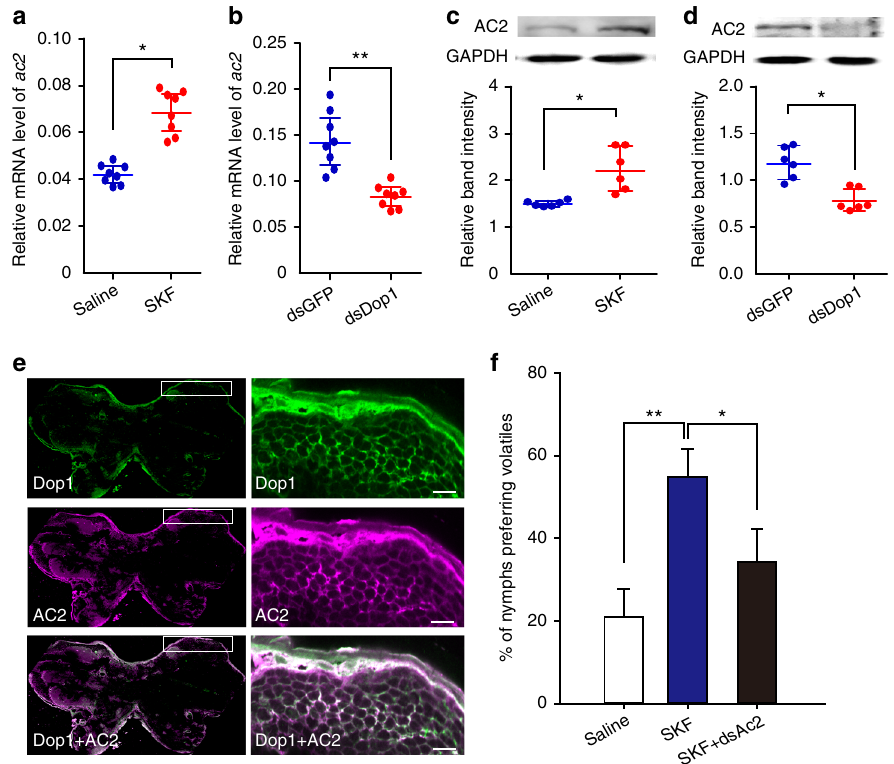
Fig. 6 ac2 responds to Dop1 administration in the brain of migratory locust. a , b The qPCR analysis showed that the mRNA level of ac2 was upregulated by SKF injection in the solitarious brains ( a , n = 8) but downregulated by dsDop1 injection in the gregarious brains ( b , n = 8). c , d Western blot analysis showed that the protein level of AC2 was upregulated by SKF injection in the solitarious brains ( c , n = 6) but downregulated by dsDop1 injection in the gregarious brains ( d , n = 6). e Co-localization of Dop1 and AC2 in the locust brain based on the immuno fl uorescence. The squares speci fi cally indicate the areas where Dop1 and AC2 were localized in the Kenyon cells of the locust mushroom body. A white signal is observed in the area with green (Dop1) and magenta signals (AC2) overlapping, indicating the co-localization of Dop1 and AC2. The images were visualized using an LSM 710 confocal fl uorescence microscope (Zeiss) at magni fi cations of ×10 (the left column) and ×20 (the right column). Scale bar represents 20 μ m. f RNAi knockdown of ac2 inhibited the olfactory preference of the solitarious locusts injected with SKF38393 ( n = 44, 40, and 44). The data in a to d are shown as mean ± SEM and the data in f are shown as p ± SE. The asterisks outside the strip indicate the signi fi cant difference between controls and the treatments through Student ’ s t -test and G -test for independence. * P < 0.05. ** P < 0.01. S: solitarious, G: gregarious, SKF: